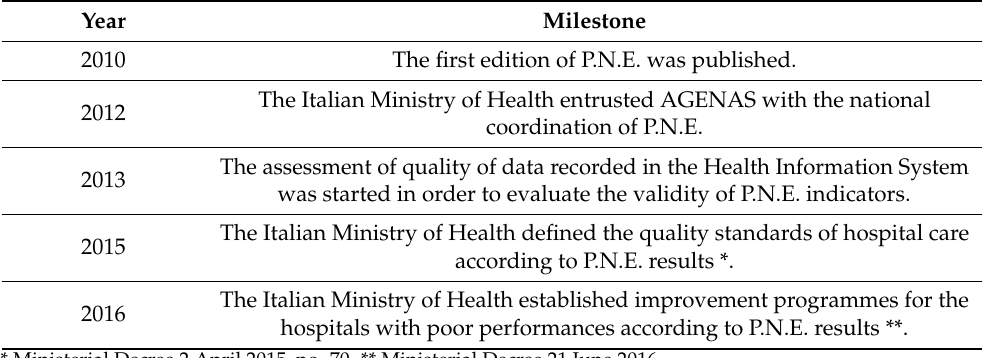
Table 1. Milestones of quality improvement in Italy. Year Milestone The first edition of P.N.E. was published. coordination of